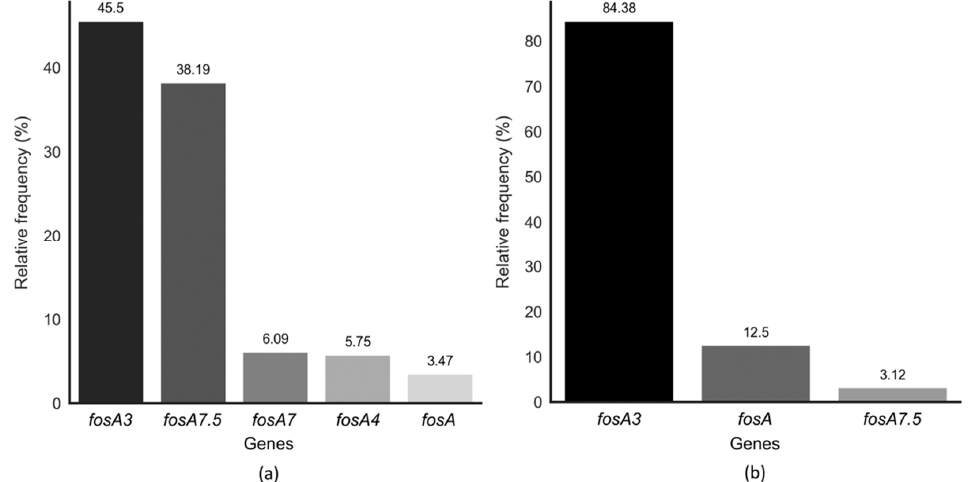
Figure 1. Occurrence of fosA alleles in Escherichia coli isolates. ( a ) Worldwide isolates; ( b ) isolates located in Brazil.